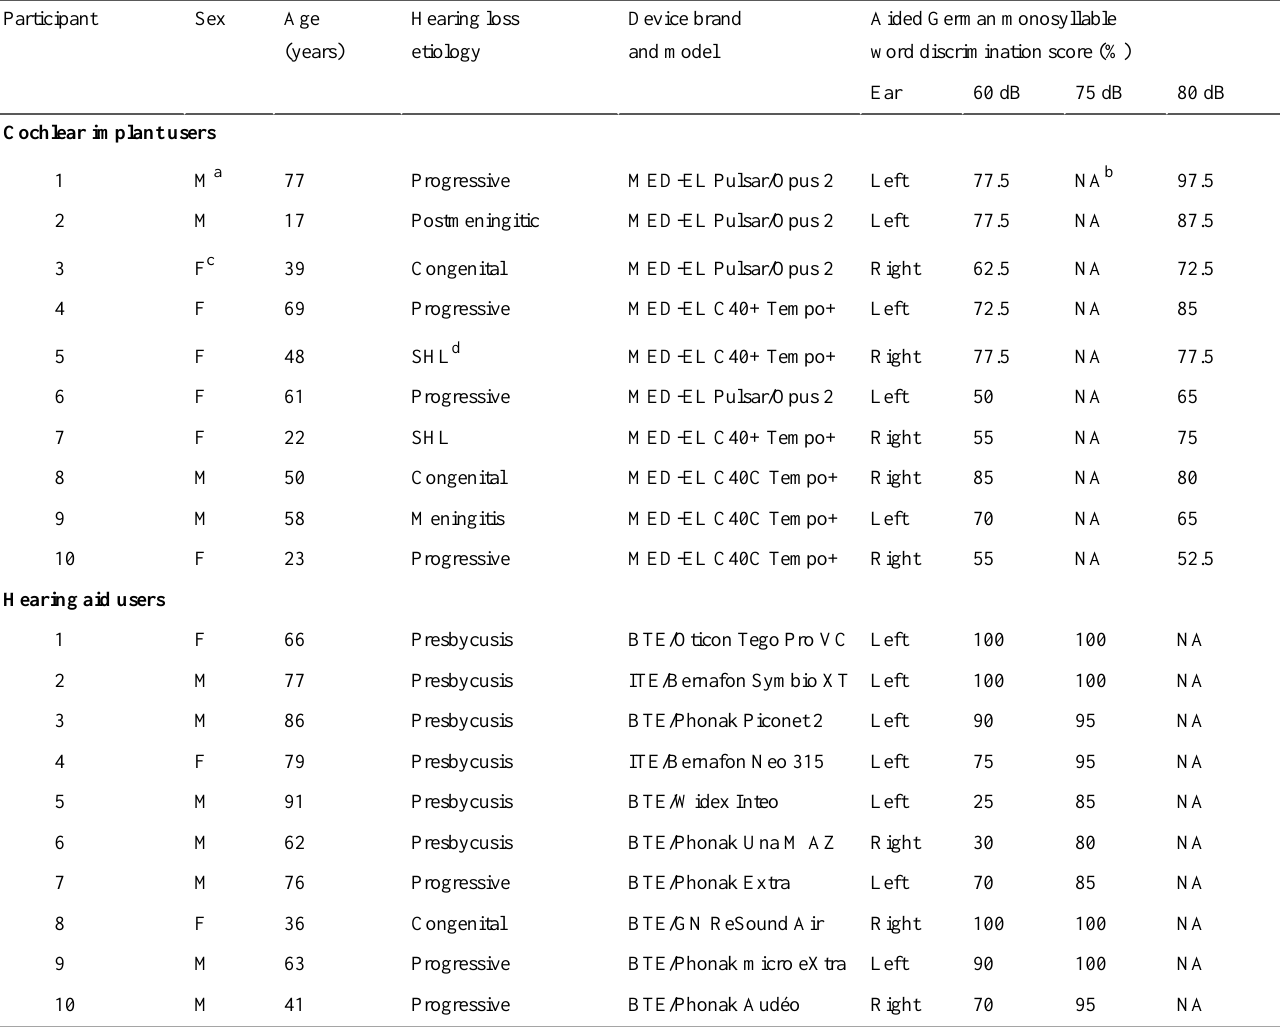
Table 1. Clinical data for cochlear implant users and hearing aid